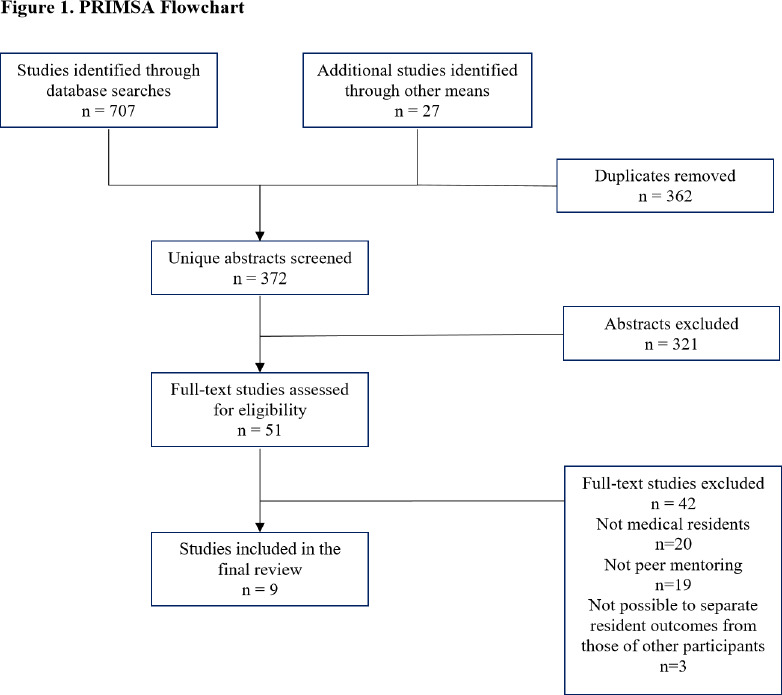
PRIMSA Flowchart